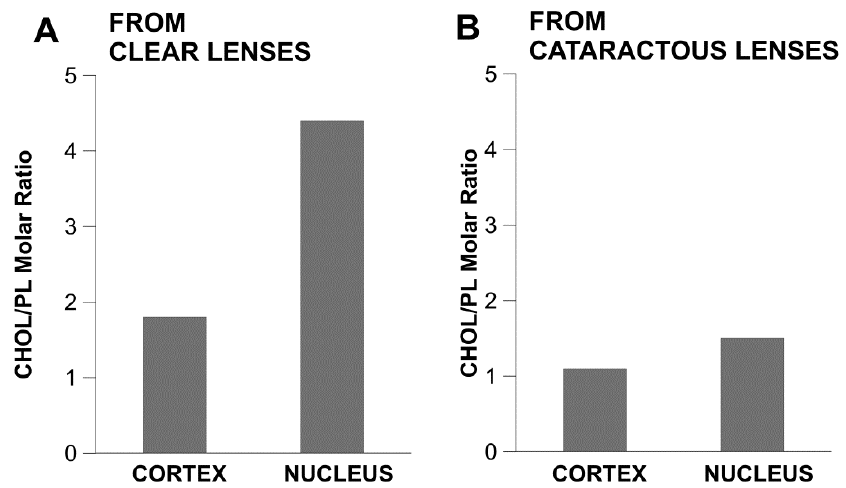
Figure 4. The cholesterol/phospholipid (CHOL/PL) molar ratio in cortical and nuclear lipid membranes of transparent and cataractous eye lenses from 61–70-year-old human donors. Values taken from